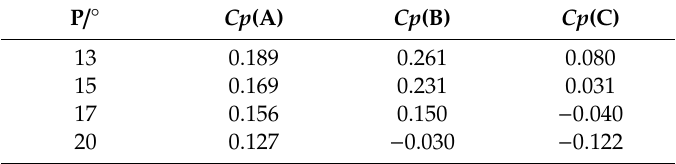
Typical pressure coe ffi cient of the BWB aircraft with di ff erent inflection angles (P = 13 ◦ / 15 ◦ / 17 ◦ / 20 ◦ , Ma = 0.75, α = 0 ◦ . The position of point A / B / C is shown in Figure 13a).